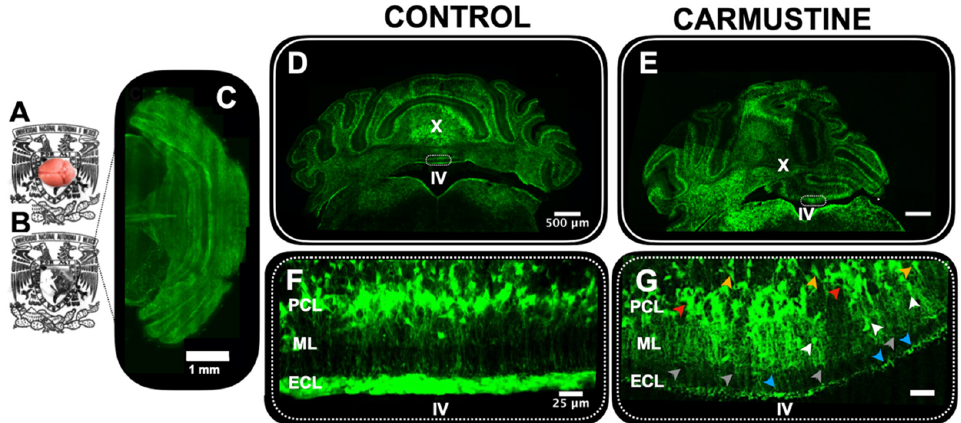
Figure 2. Morphological evidence of cortical dysplasia in the cerebellum. ( A ). Five-day-old male GFAP-eGFP transgenic mouse brain, before ( A ) and after clarification ( B , C ). Dorsal view of the brain in ( B ) reconstructed by light sheet microscopy. ( D ). Coronal section of the cerebellum of a male P5 GFAP-eGFP transgenic control mouse. ( E ). Coronal section of the cerebellum of a male P5 GFAP-GFP transgenic mouse treated with carmustine showing the presence of cortical dysplasias in the lobules in contact with the IV ventricle ( F ). Magnification of the square in ( D ); here Bergmann cells are situated in the Purkinje cell layer, projecting their processes through the molecular layer. ( G ). Magnification of the square in ( E ), where Bergmann cells are seen displaced towards the granular layer (orange arrowheads) and the molecular layer (white arrowhead) with disrupted processes (gray arrowhead); as well as the presence of cell clusters and heterotopias evidenced in the Purkinje cell layer (red arrowhead) and ependymal cell layer (blue arrowhead). (Control n = 5, Carmustine n = 5) Green: GFAP + glial cells. ML: molecular layer, PCL: Purkinje cell layer, GCL: granule cell layer, ECL: ependymal cell layer.